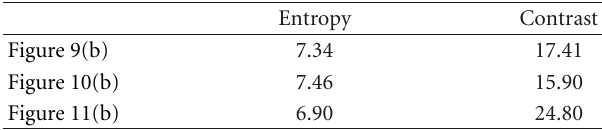
Table 3: Focusing indicators for the live ISAR images in